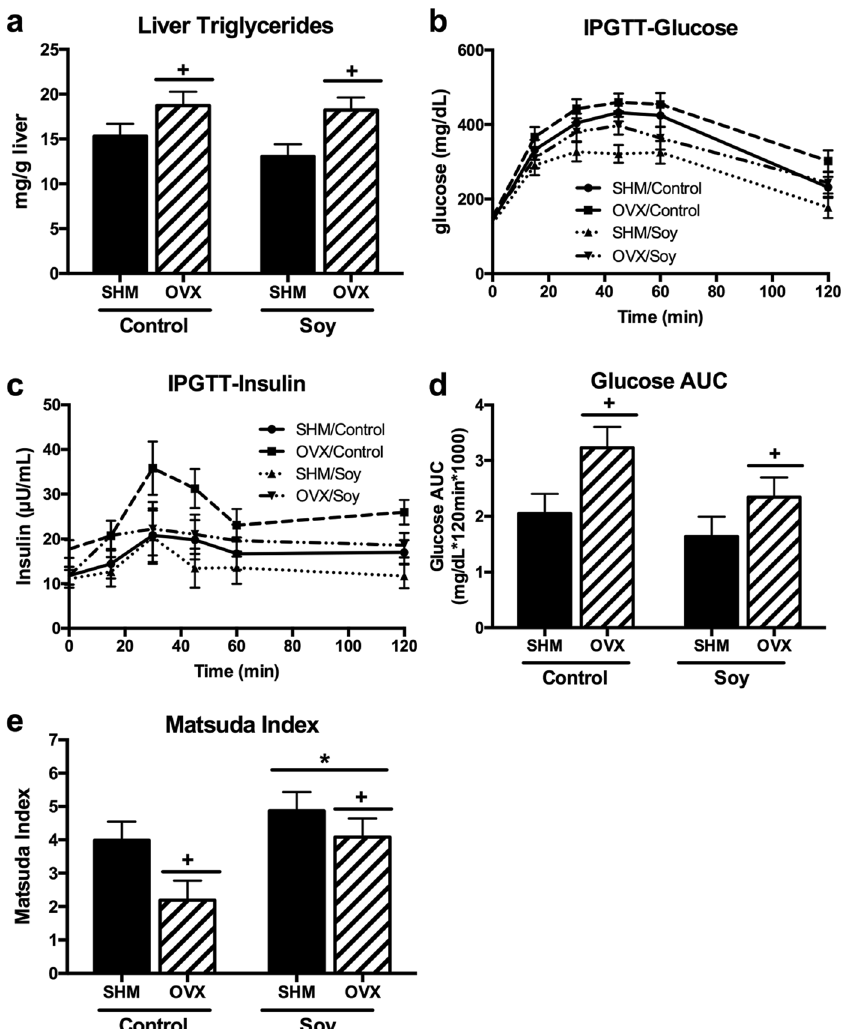
Figure 2. OVX led to greater concentrations of liver triglycerides ( a ). Intraperitoneal glucose tolerance test was performed at 19wk post-surgery and glucose ( b ) and insulin ( c ) changes over time was plotted. Corresponding glucose area under the curve (AUC) ( d ) and Matsuda Index ( e ) was calculated from ovariectomized (OVX) vs. sham-operated (SHM) rats bred for low-running capacity fed either a soy-rich or soy-free diet. Data were analyzed using the Mixed Models procedure of SAS 9.3 with diet and surgery being fixed effects and animal ID being a random effect. When a main effect was significant, post hoc pairwise comparisons were performed using Tukey’s multiple comparison tests. Data are least-squares means ± SEM, n = 4–10. + Denotes main surgery effect (OVX vs. SHM); * Denotes main diet effect (Control vs. Soy), P <